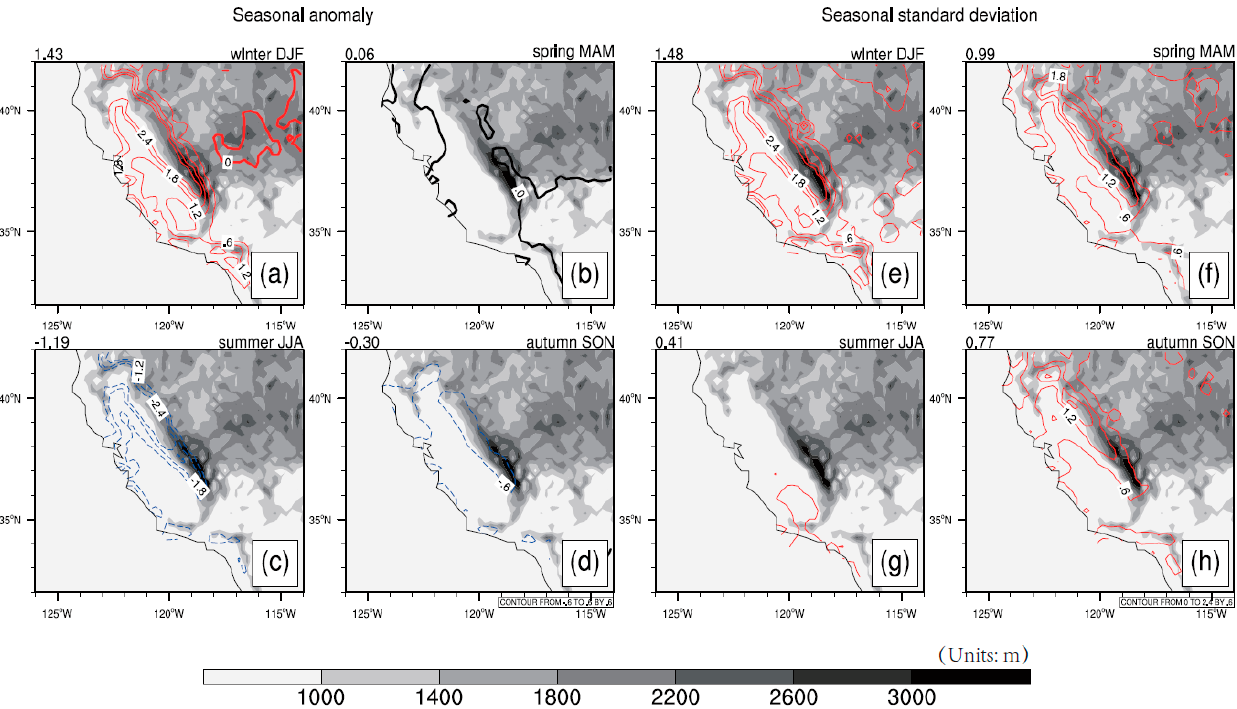
Figure 1. Seasonal anomalies ( a – d ; mm/day) and standard deviation ( e – h ) of precipitation in winter ( a , e ), spring ( b , f ), summer ( c , g ), and autumn ( d , h ) during 1948–2020. The climatology is based on the time period of 1951–1990 over land and 1979–1998 over oceans. Shading denotes altitude (m). Box-averaged variables are shown above each panel.